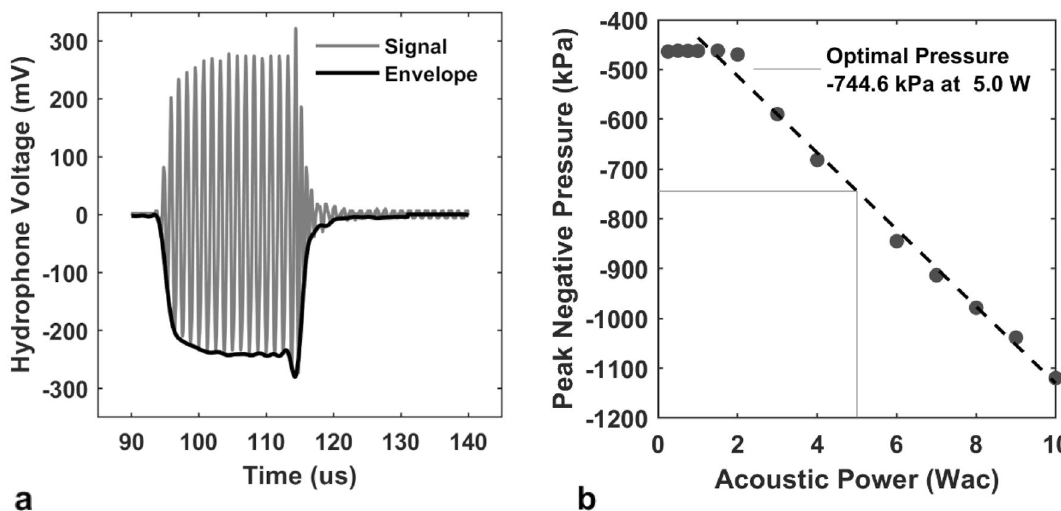
Figure 3. Detuned 800 kHz Sonalleve hydrophone measurements at the focus. ( a ) Manual 16-cycle bursts were sent to the Sonalleve transducer, and the subsequent voltage was measured approximately 90 µs after using a manual trigger. The peak negative pressure was calculated as the plateau voltage after filtering through an envelope detector multiplied by the hydrophone sensitivity factor. ( b ) Peak negative pressures plotted as a function of acoustic power on the Sonalleve console. A negative linear trend was observed between 1.75 and 10 Wac (n = 9 points). Without any attenuation, approximately 750 kPa peak negative pressure can be achieved using 5